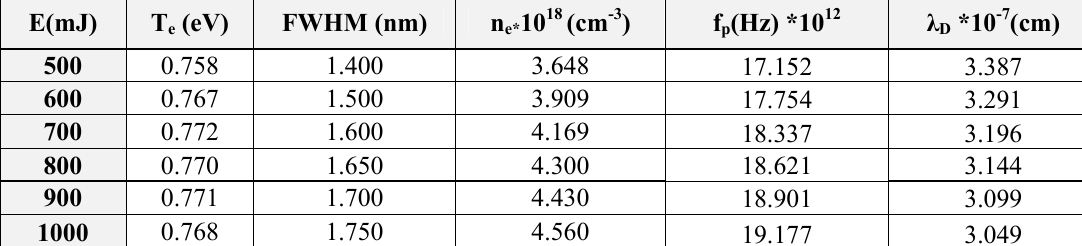
Table 1: Plasma parameters for CdTe:Swith different laser energy.